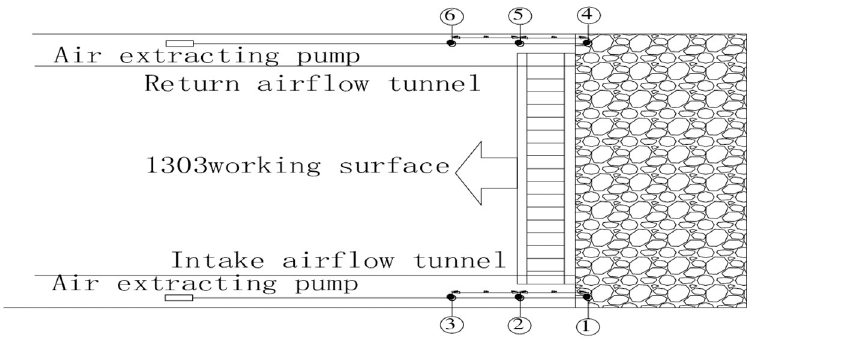
Fig 1. Layout of beam tube and temperature sensor.